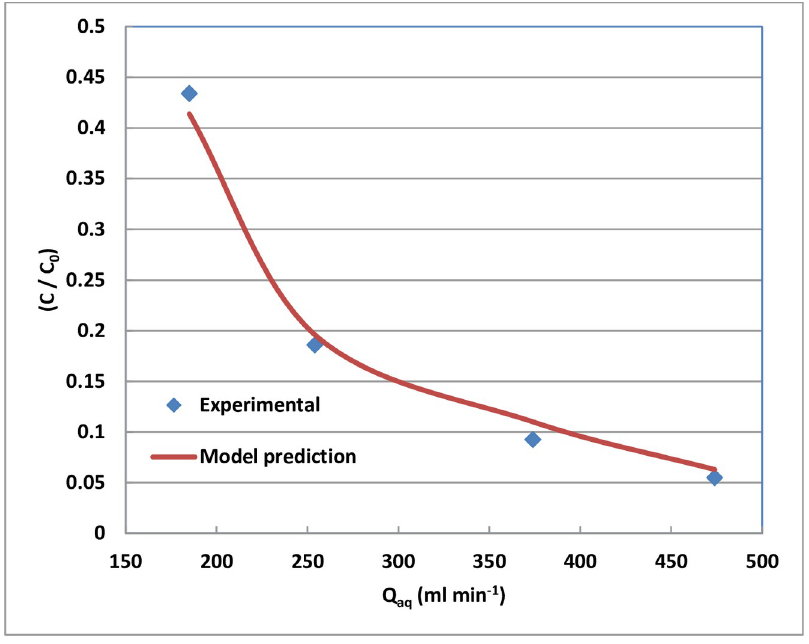
Fig 3. Validation of model’s prediction with experimental data reported by Williams et al. [8]. Q org = 166 ml min - 1